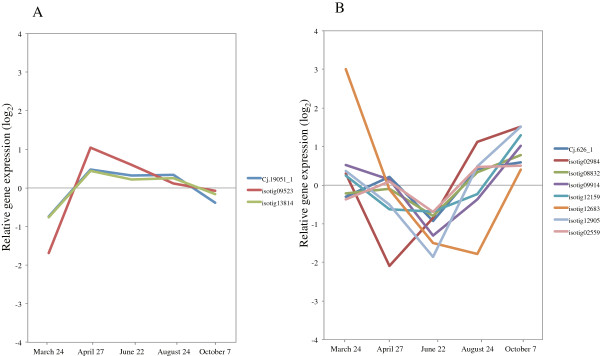
Expression of peroxidase superfamily in cambial region during xylem formation. A) Genes upregulated in activity period. B) Genes upregulated during dormancy and cessation of growth. The individual targets are summarized in Additional file 3. All expression data are presented on a log2 scale.